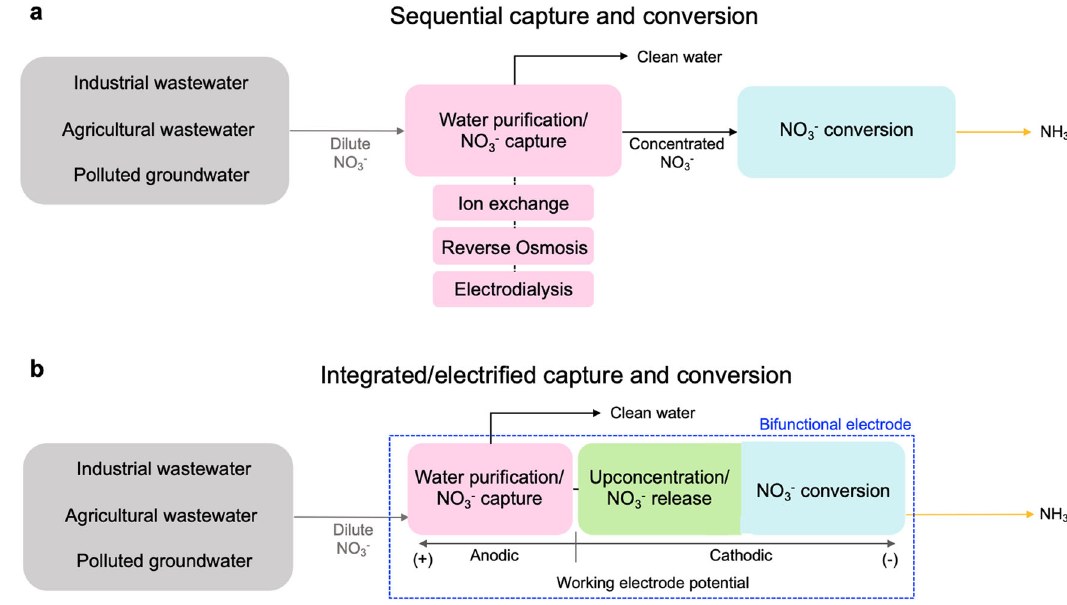
Fig. 1 | Sequential and integrated pathway for dilute nitrate capture and con- version. a A schematic illustration of the sequential route of physicochemical puri fi cation (ion exchange, reverse osmosis, and electrodialysis) and